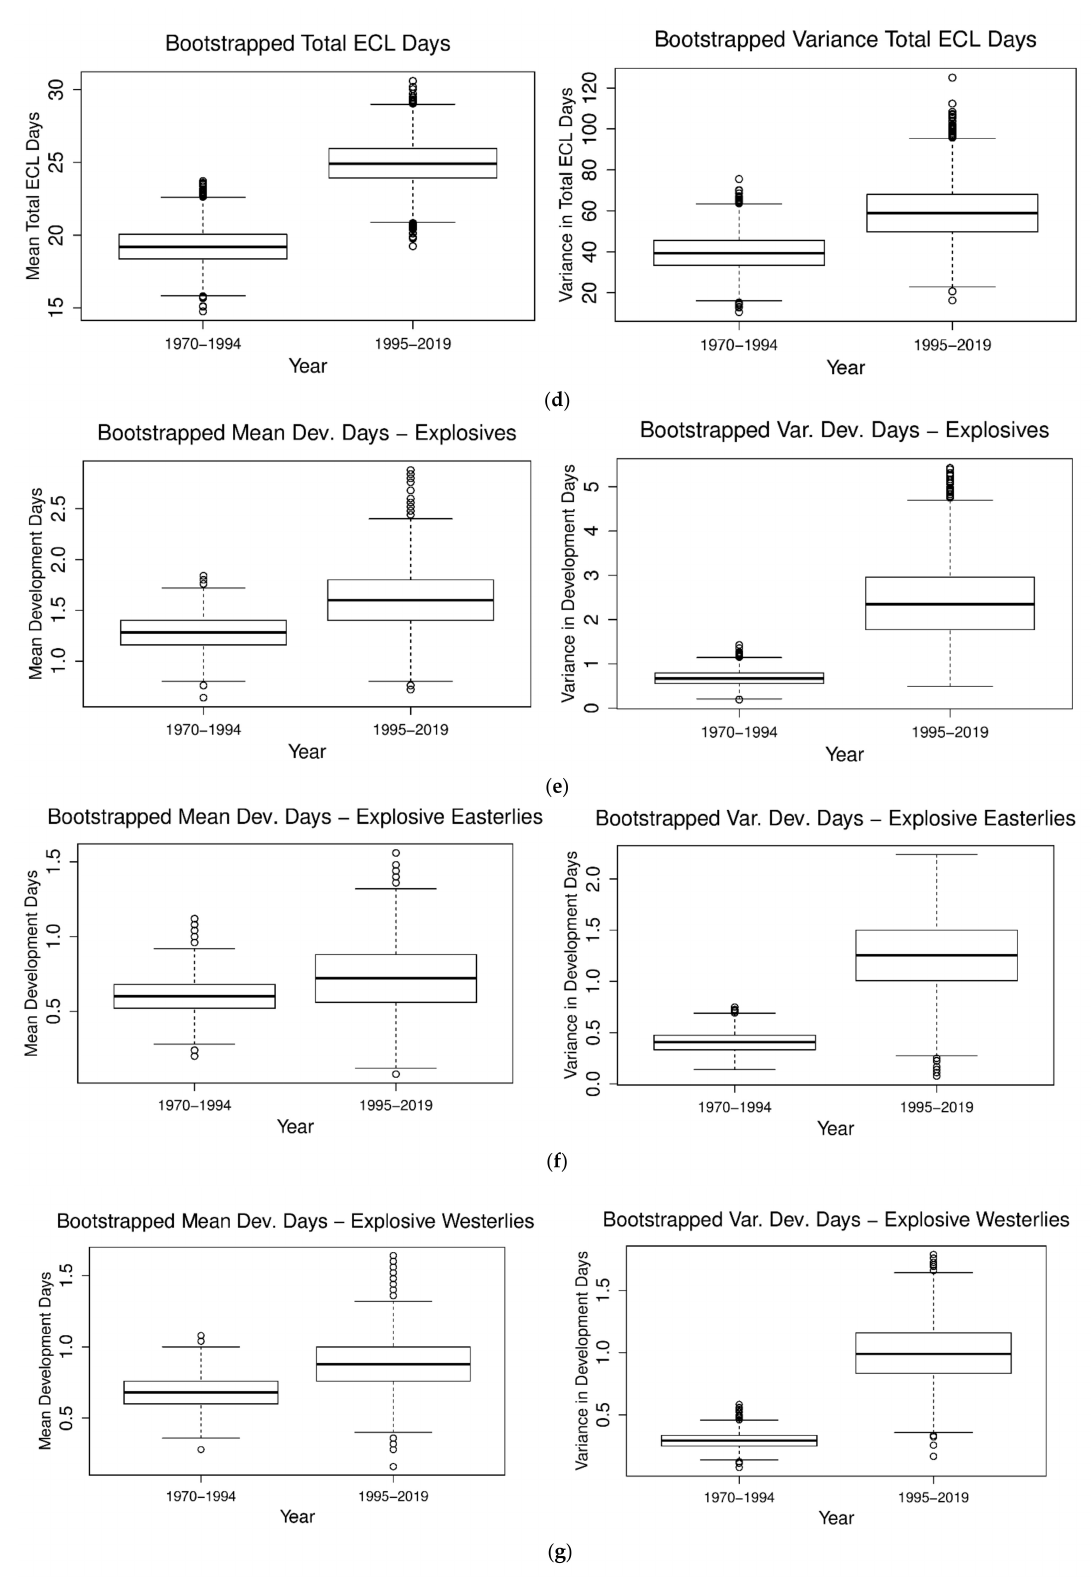
Figure 3. Box and whiskers plots of bootstrapped ECL counts of significant mean ( left panel ) and/or variance ( right panel ) for the periods April–September 1970–1994 and 1995–2019, ( a ) Total Dev. days, ( b ) Total Dev. days Westerlies, ( c ) Total days of Westerlies, ( d ) Total days of lows, ( e ) Total Dev. days Explosives, ( f ) Total Dev. days Explosive Easterlies, ( g ) Total Dev. days Explosive